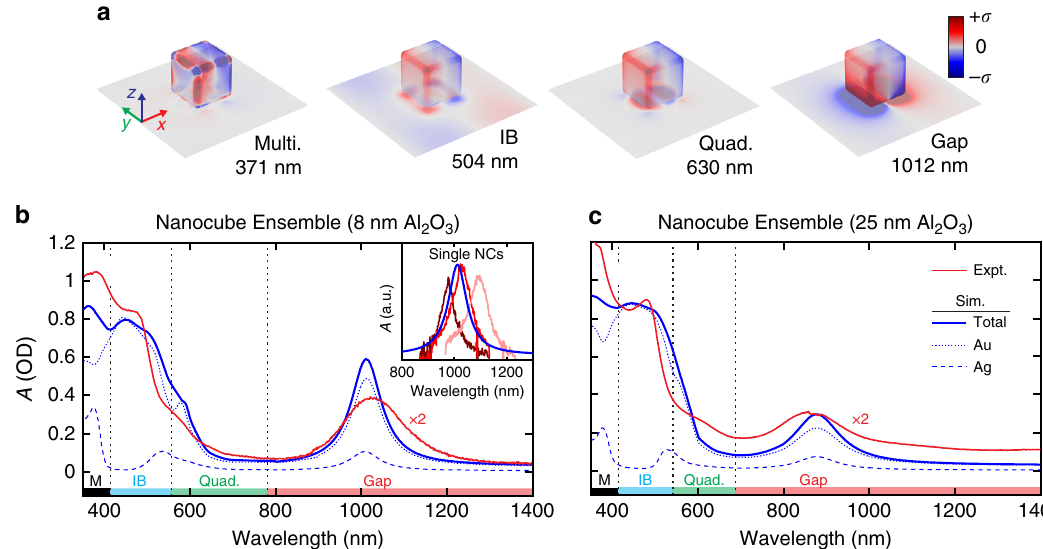
Fig. 3 3-D maps of surface charge distributions with experimental and calculated absorbance spectra. a Surface charge distributions (arbitrary units) for the 8 nm Al 2 O 3 sample at the indicated wavelengths corresponding to the multipolar mode (M), the gold interband transition (IB), the quadrupolar mode (Quad), and the gap plasmon mode (Gap) calculated with COMSOL assuming normally incident light polarized along the x -direction. Steady-state absorbance is simulated for samples with an 8 nm ( b ) or 25 nm ( c ) Al 2 O 3 spacer assuming a nanocube density of 4 μ m − 2 and compared to the experimental ensemble response of the metasurface. The calculated absorbance is also broken down into the relative contributions to absorbance from the Ag and Au components. The inset to b is a comparison of three experimental absorbance spectra of single nanocubes (NCs) at the gap mode to the simulated spectrum, showing an excellent agreement between homogeneous